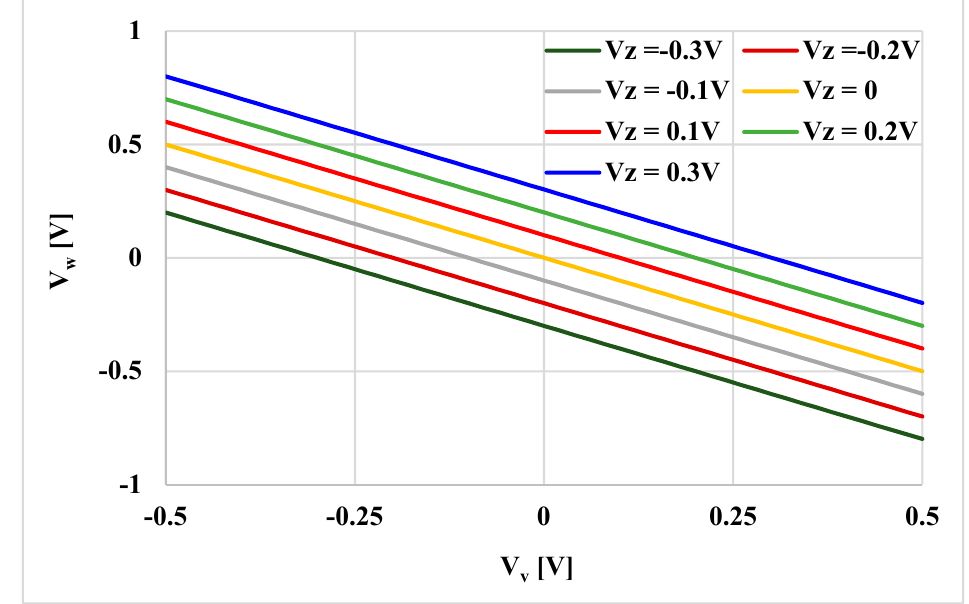
Figure 7. The output voltage V W versus the input voltage V v for different V z .